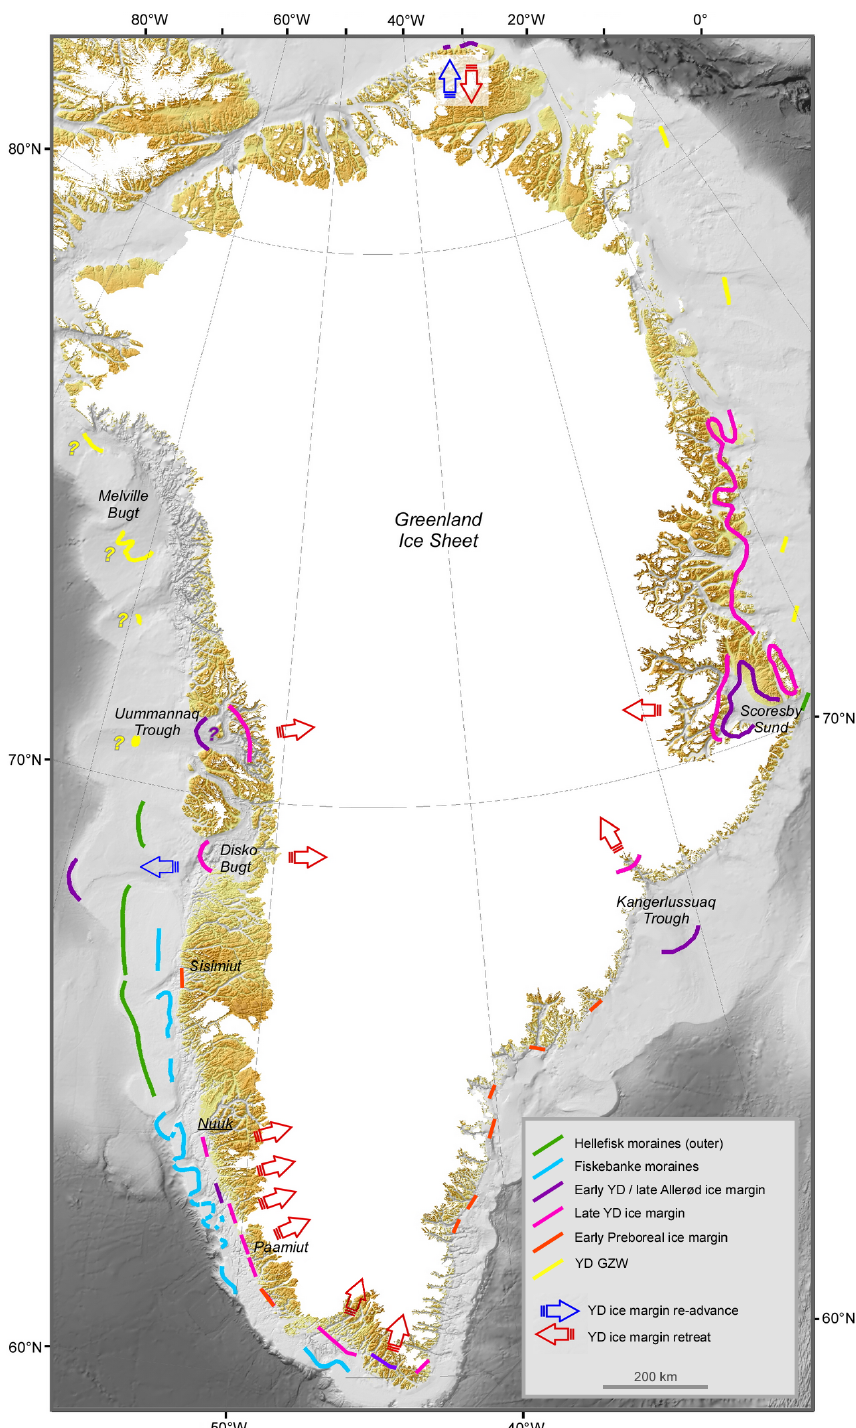
Figure 4. Deglacial ice margin features in Greenland discussed in the text. Question marks at grounding zone wedges apply to age and come from the original literature. Sources are Larsen et al. (2016) and the references discussed in the text. The background map of Greenland and surrounding seas is from BedMachine Greenland v.3 (Morlighem et al.,